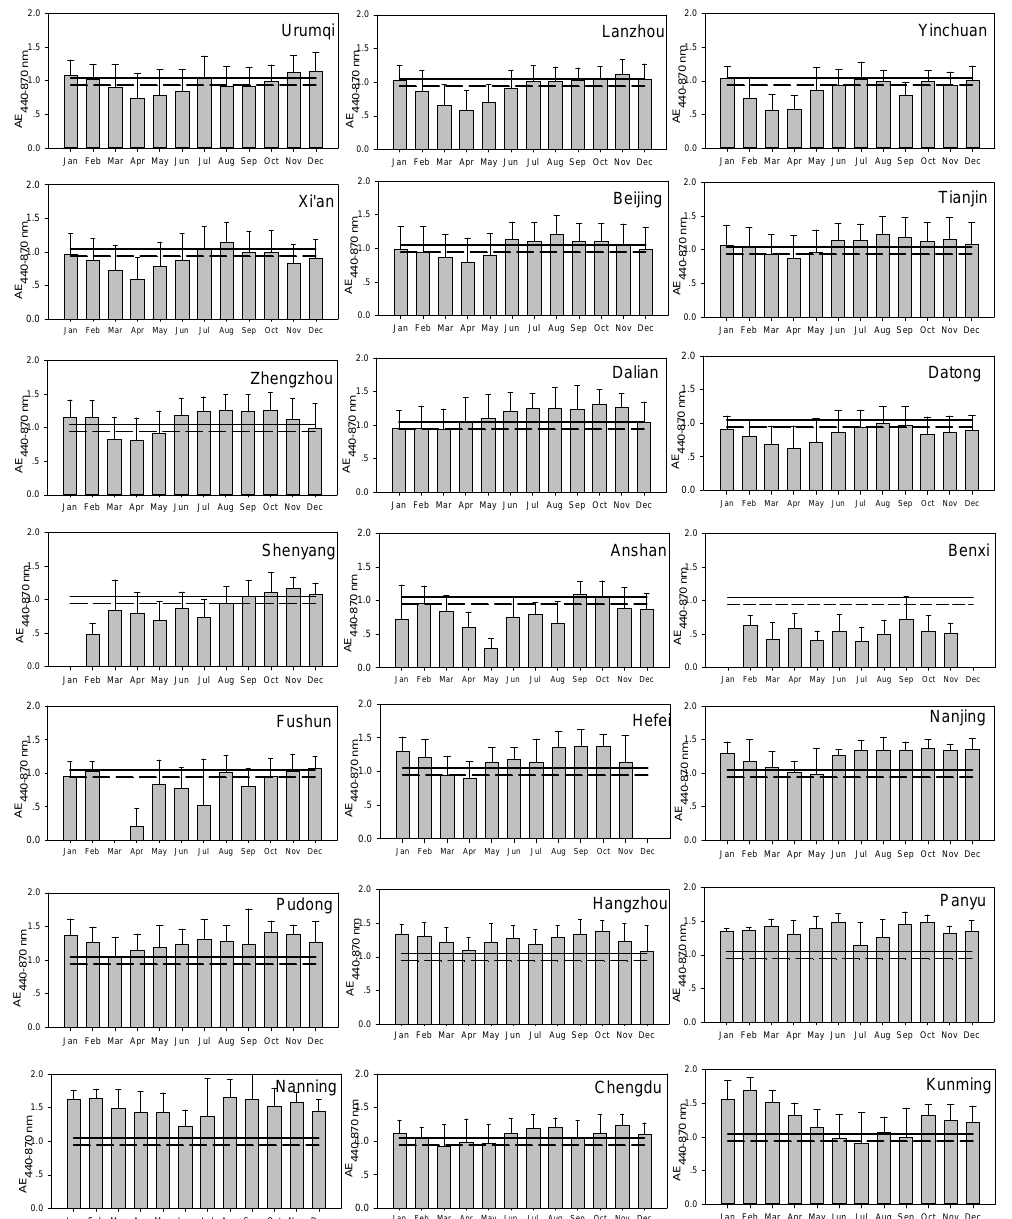
Figure 15. Monthly averaged AEs between 440 and 870nm at urban sites. The solid and dash horizontal hairlines indicate the annual averages for the subgroup and the whole database,